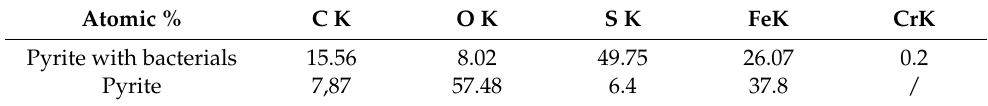
Table 2. EDS spectrum analysis of pyrite surface in different